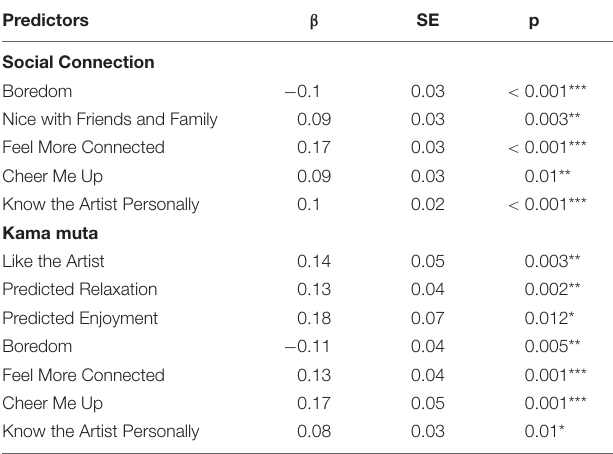
TABLE 2 | The effect of concert attendance motivations on (A) social connection and (B) kama muta